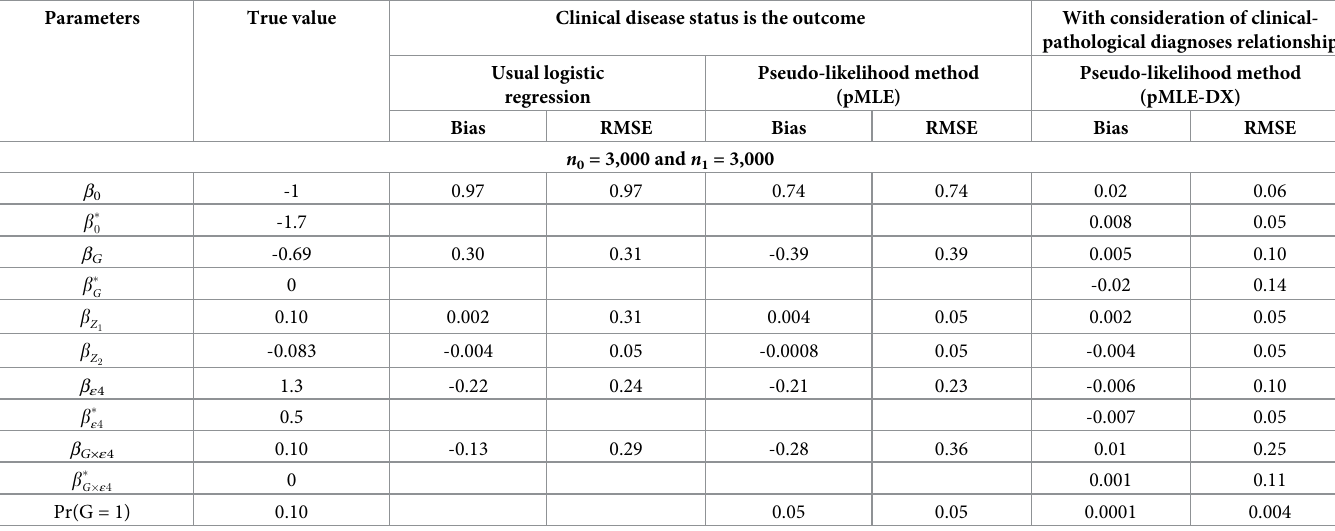
Table 3. Bias and RMSE in parameter estimates when β (cid:3) Parameters True value Clinical disease status is the outcome With consideration of clinical-